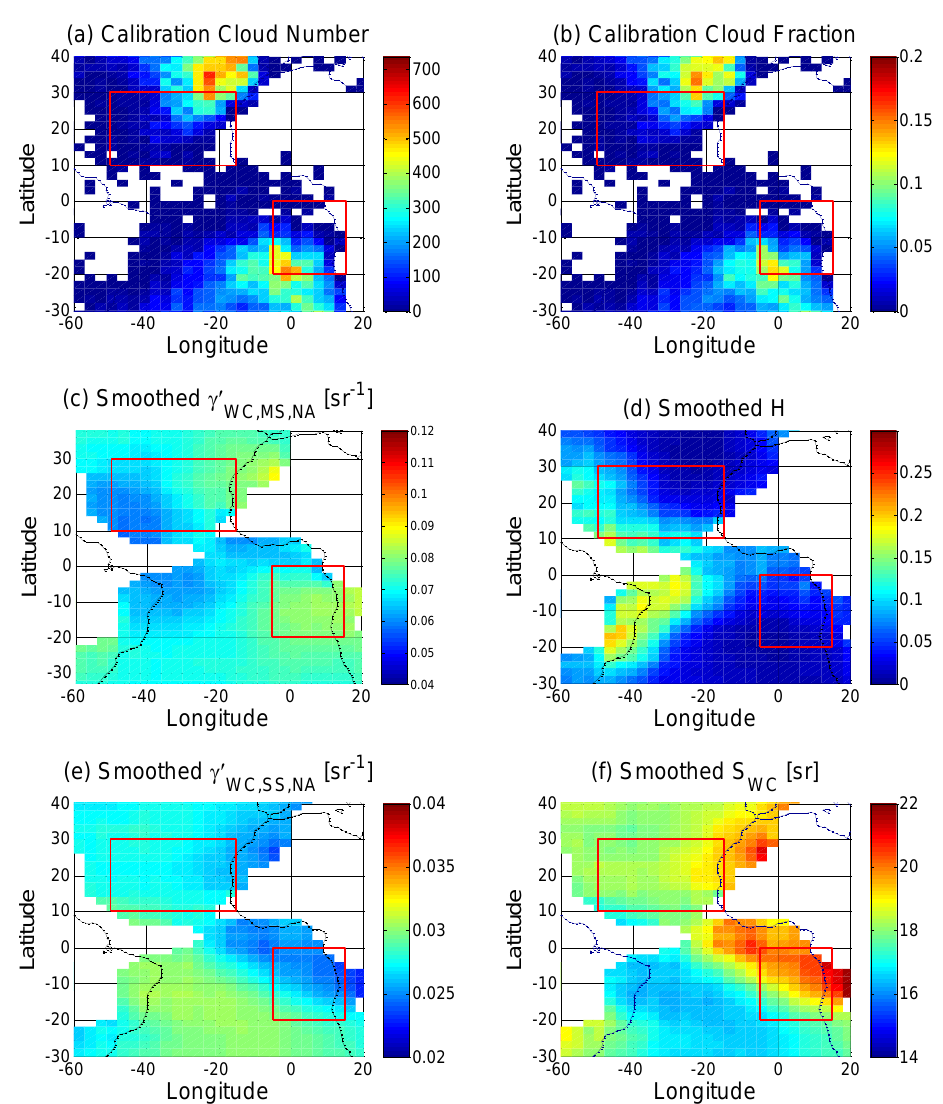
Figure 3. Spatial distributions of (a) number of calibration opaque water clouds above which no other cloud or aerosol layer was de- tected, (b) the fraction of calibration clouds relative to the total samples in each grid, (c) smoothed mean integrated attenuated backscatter, r WC,top (cid:48) (r) d r , from opaque water clouds in (a) , (d) H calculated using Eq. (4), (e) mean integrated attenuated single- γ (cid:48) = R r WC,base B WC, SS, NA = γ (cid:48) H, calculated from (c) and (d) and used as a reference in each grid box, and (f) water scattering backscatter, γ (cid:48) WC, SS, NA WC, TS, NA cloud lidar ratio S WC = 1 / 2 γ (cid:48) (i.e., Eq. 5) calculated from (e) . The grid box size is 2 ◦ × 3 ◦ (lat × long). The smoothing window WC, SS, NA is a 10 ◦ × 15 ◦ grid. The white color represents the grids having no data samples. Data is from all nighttime CALIOP measurements